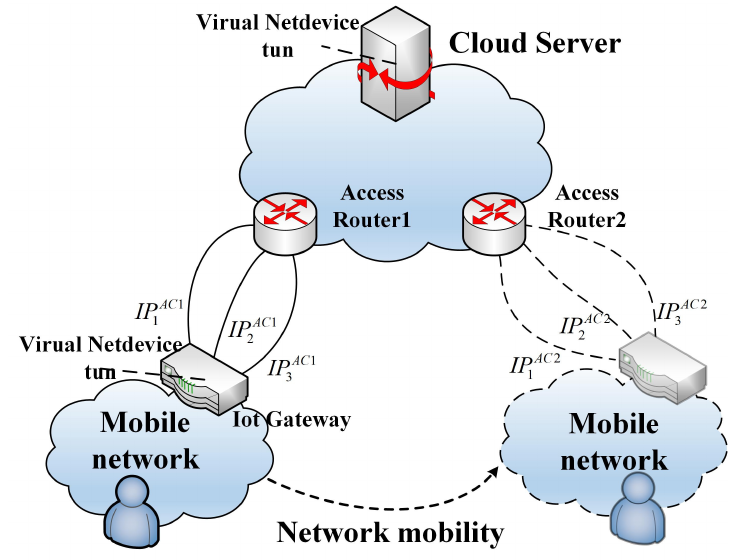
Figure 10. Simulation of the mobile heterogeneous networks through the design of link parameters and IP